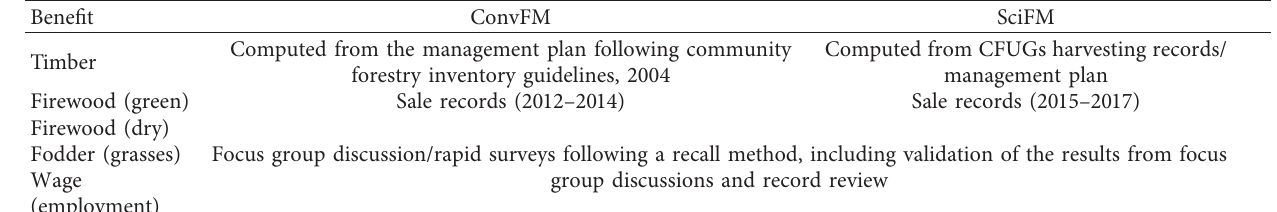
Table 3: Methods followed for the estimation of benefits.